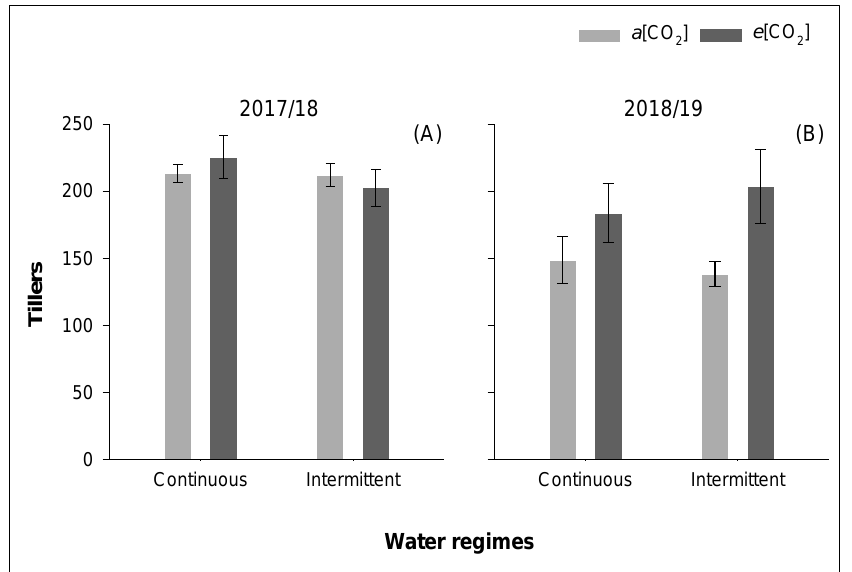
Figure 1. Effects of CO 2 concentration ( a [CO 2 ] = 400 μmol mol −1 and e [CO 2 ] = 700 μmol mol −1 ) and irrigation regime (continuous vs. intermittent flood) on rice tillers per bin in 2017/18 ( A ) and 2018/19 ( B ). Error bars correspond to 95% confidence intervals about means.